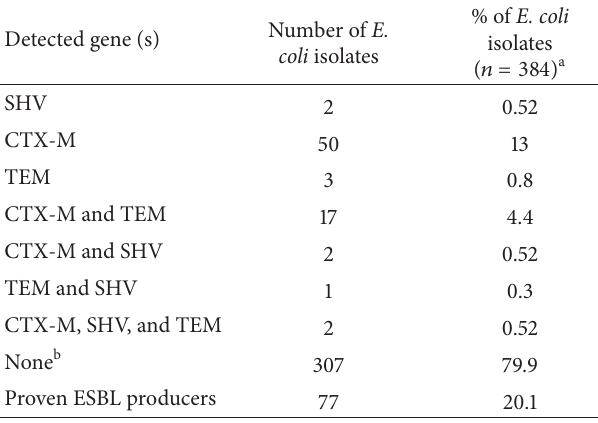
Table 1: Confirmed ESBL-producing E. coli (using PCR and gene detection) isolates.